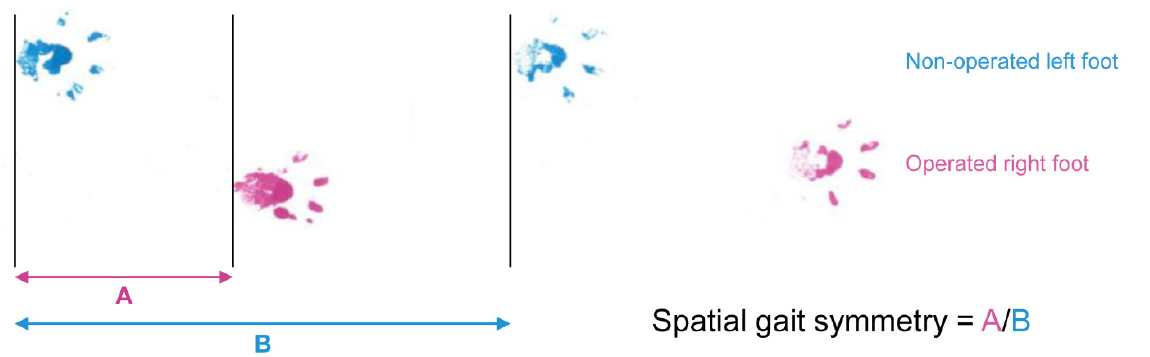
Figure 3. Spatial gait symmetry test.